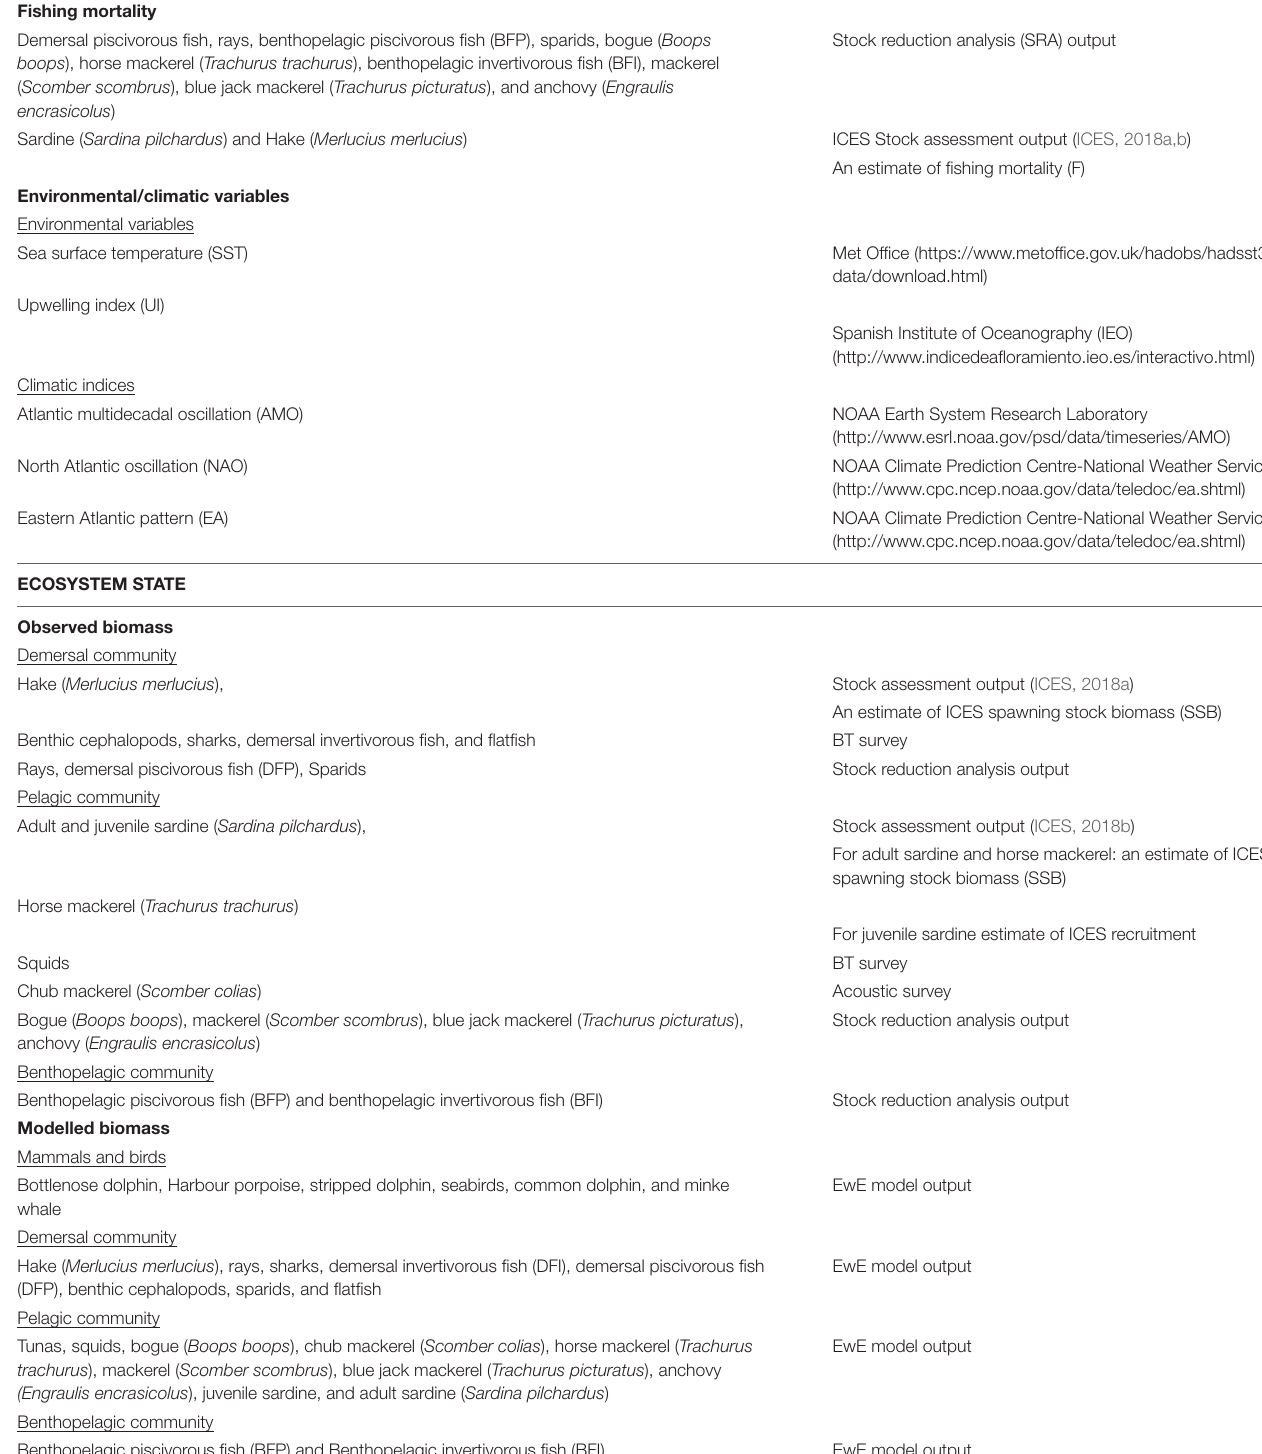
TABLE 1 | Groups of data used in integrated trend analysis (ITA) and their sources. Data groups Source Ecosystem